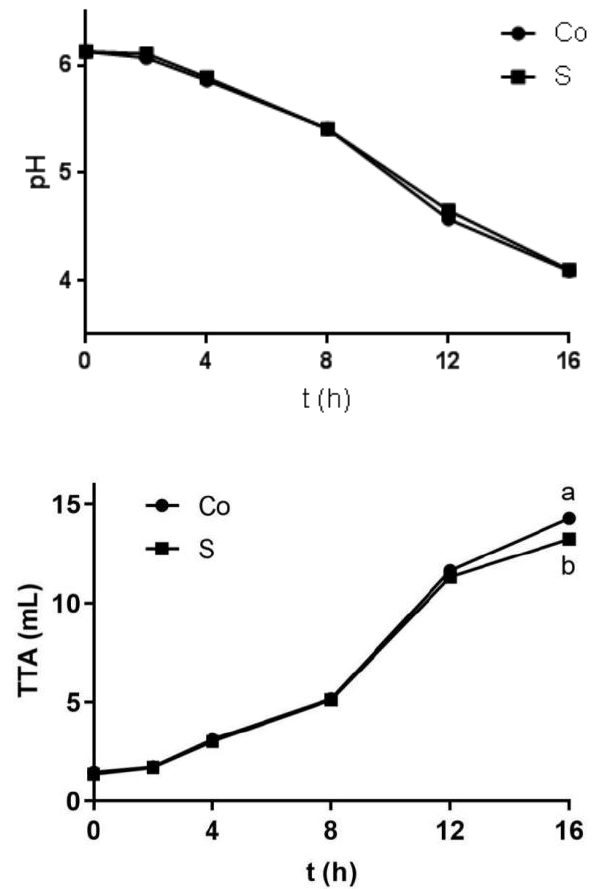
Figure 3. The effect of S. aureus contamination on pH and TTA of sourdough, with Co and S indicating wholewheat sourdough and wholewheat sourdough artificial contaminated with S. aureus (10 2 cfu/g); a,b means in each bar having different letters are significantly different ( p < 0.05, n = 6).